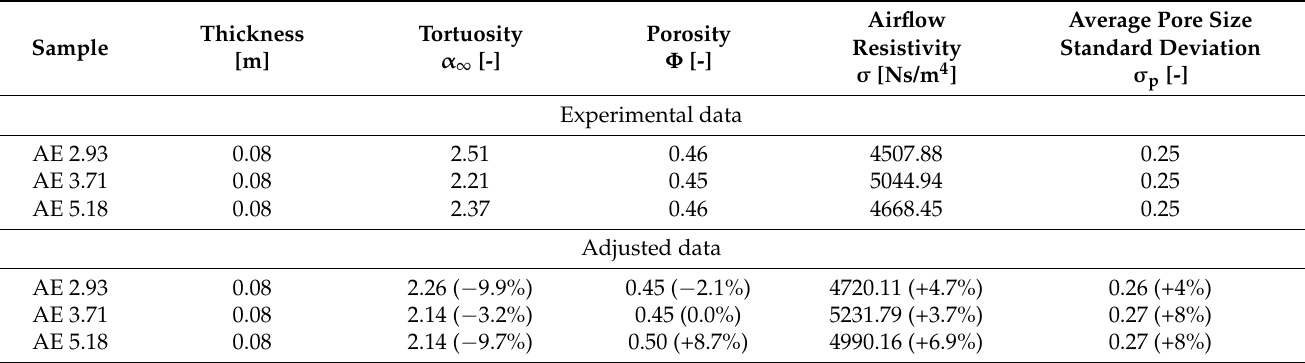
Table 2. Experimental and corrected macroscopic parameters